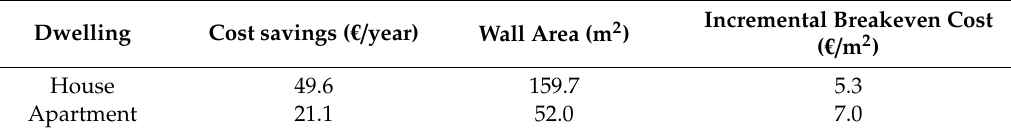
Table 11. Cost analysis for the two dwellings when configured with the improved walls.